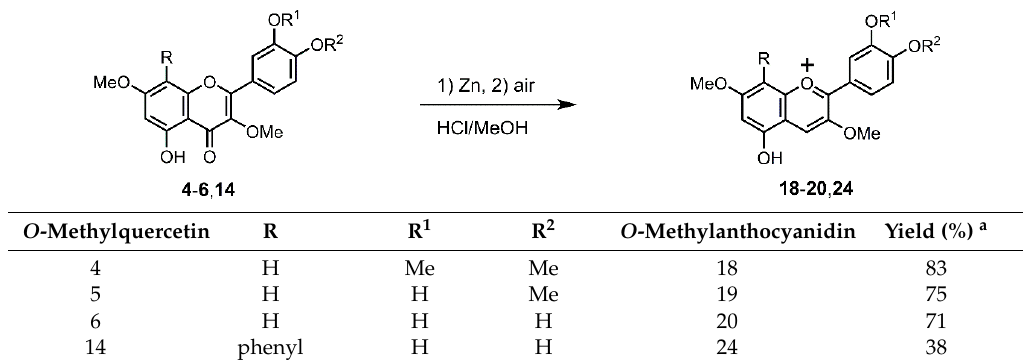
Table 3. Synthesis of O -methylanthocyanidins ( 18 – 20 , 24 ) using Zn. a Isolated yield.